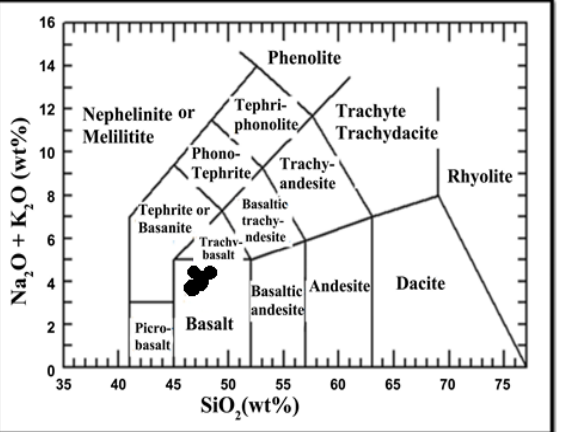
Table 3. Geochemical composition of pumice rock in (wt %).